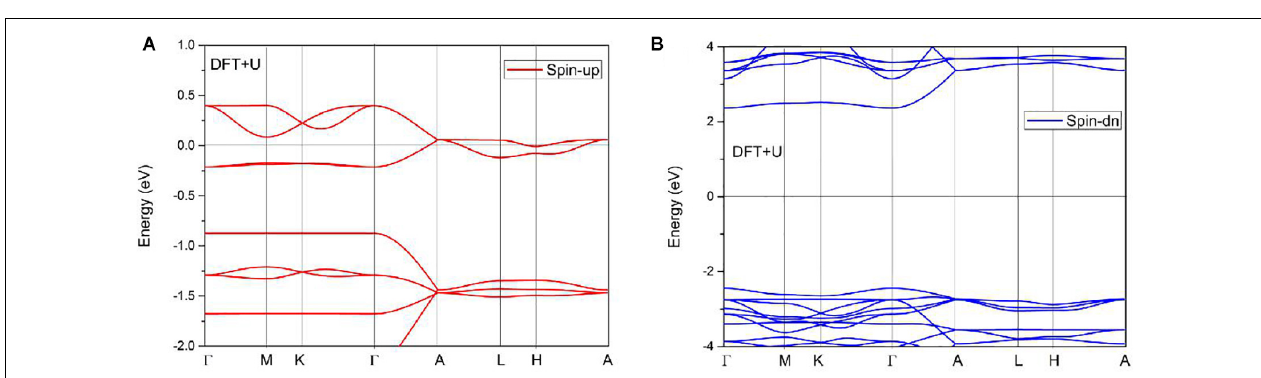
FIGURE 3 | Spin-polarized band structures of CsCrCl 3 system via GGA method. (A) for spin-up and (B) for spin-down.